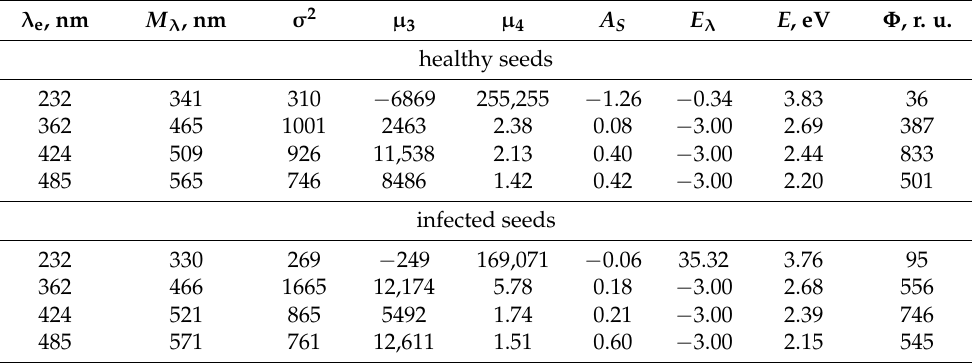
Table 3. Statistical parameters of photoluminescence spectra of wheat